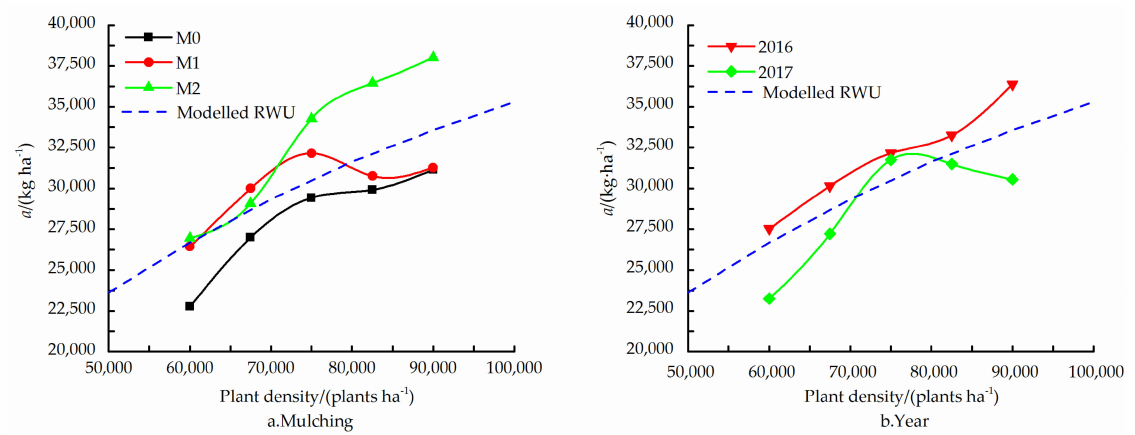
Figure 4. Final DMA ( a ) as function of PD for no (M0), transparent (M1) and black (M2) film mulching treatment (( a ), mean of 2016 and 2017), and for the two experimental years (( b ), mean of three mulching treatments). Also shown is the a ( ρ ) relationship according to the fitted relative water uptake relationship.